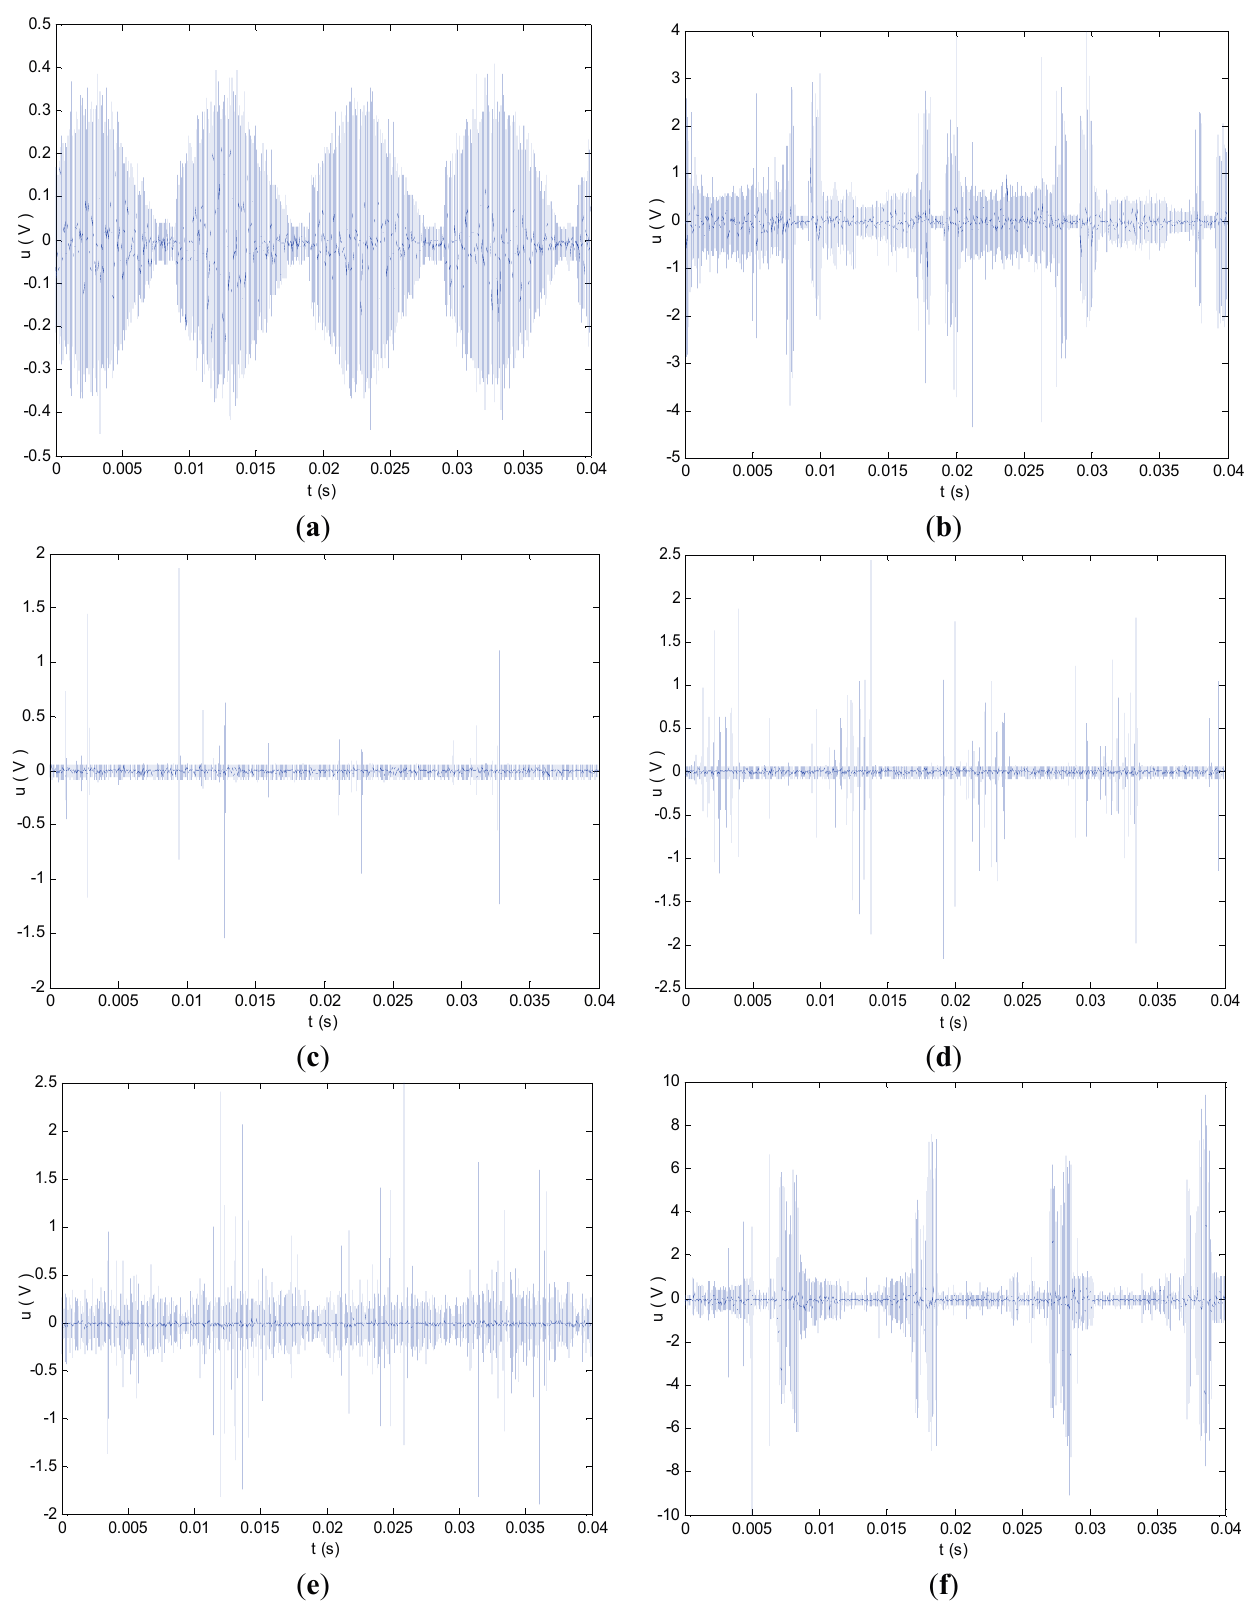
Figure 2. Detected high frequency signals of different load states. ( a ) Halogen lamp normal; ( b ) Halogen lamp arc fault; ( c ) Vacuum cleaner normal; ( d ) Vacuum cleaner arc fault; ( e ) Electrical drill normal; ( f ) Electrical drill arc